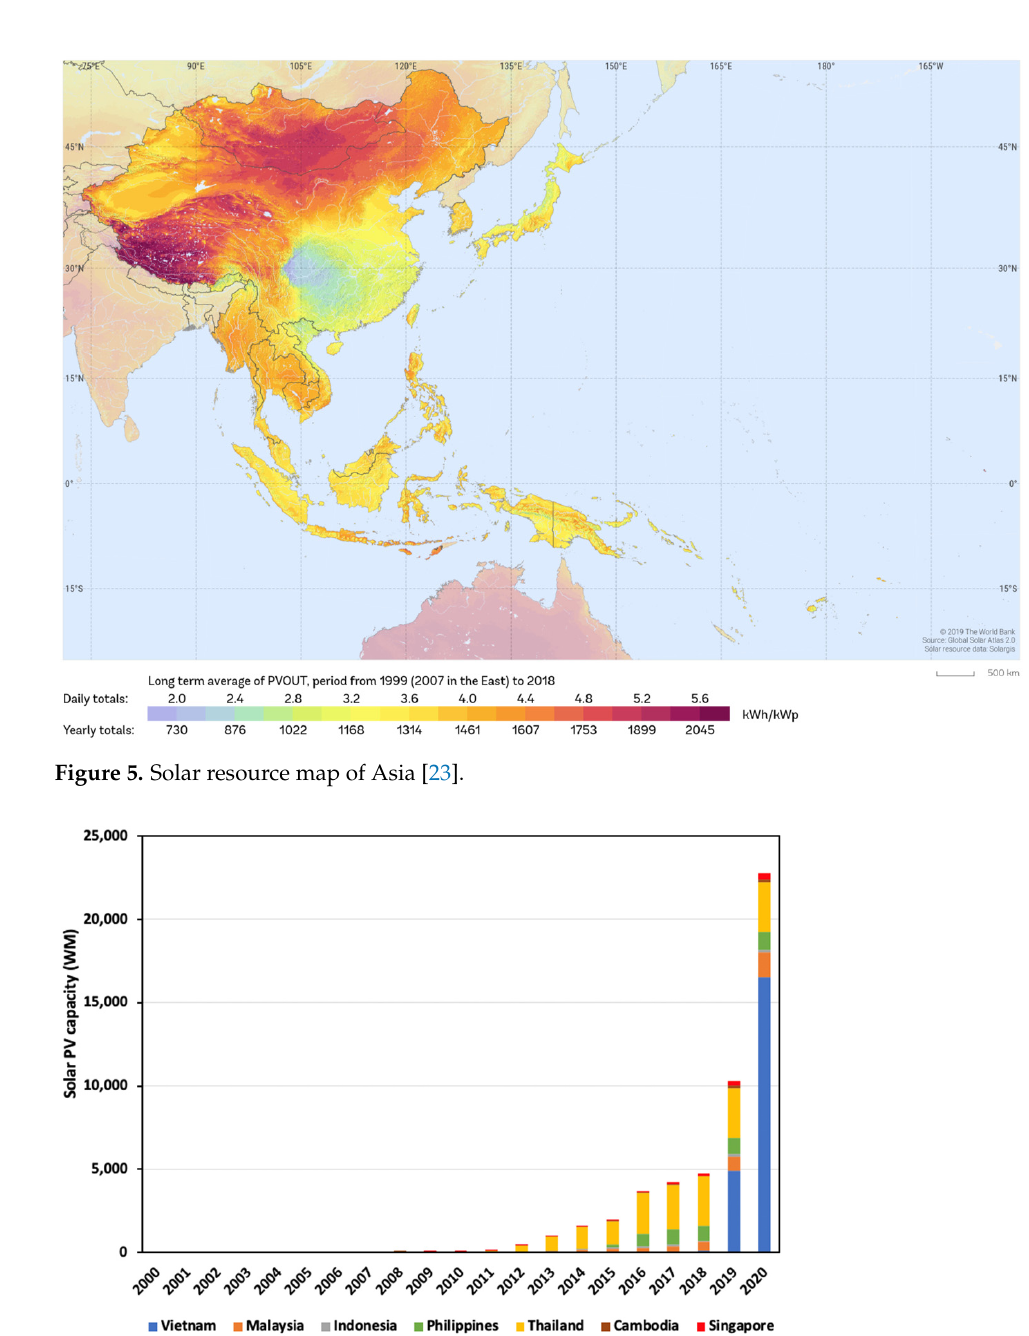
Figure 6. History of installed solar PV capacity in ASEAN [22] .